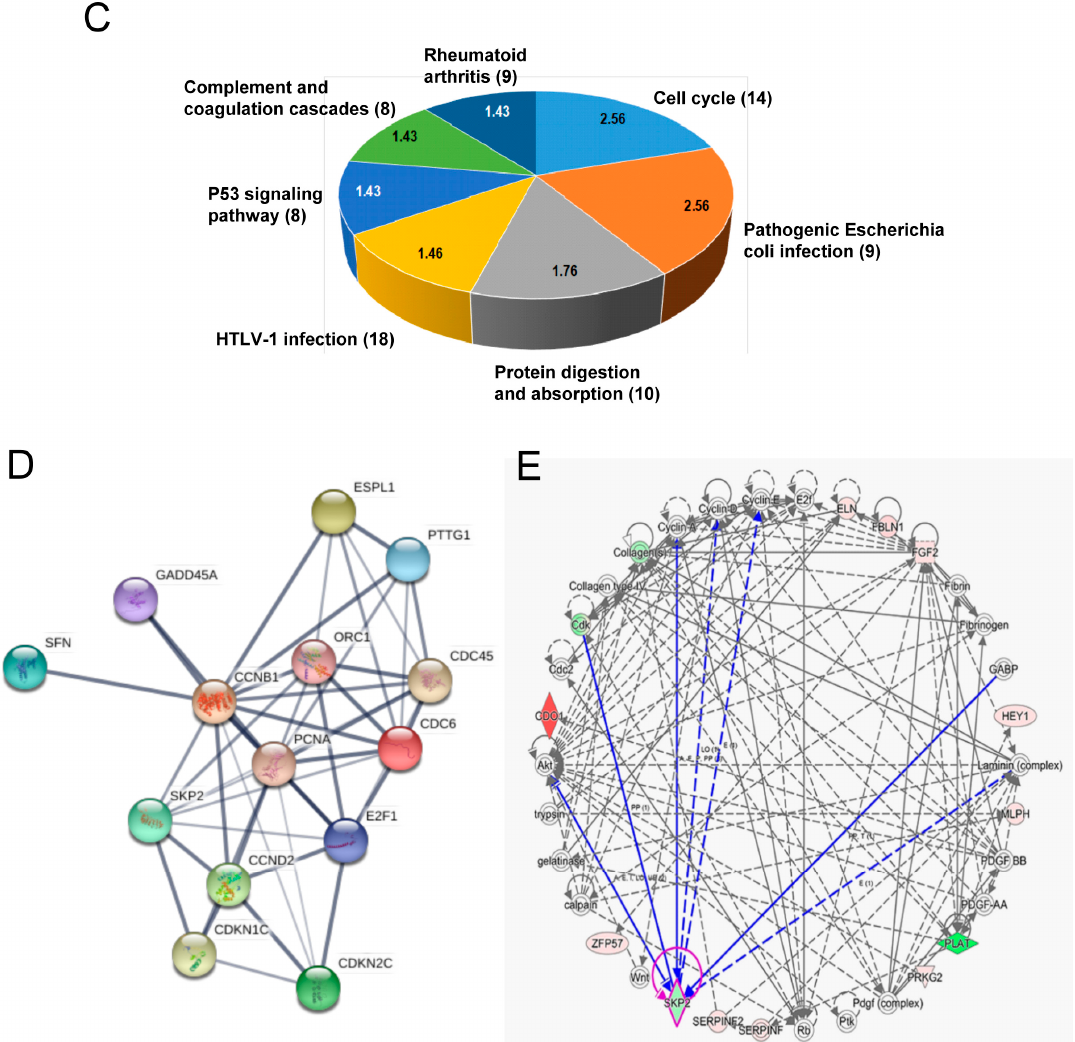
Figure 2. Identification of potential genes associated with cell senescence in PTECs in DN. ( A ) Flowchart of identification of potential genes associated with cell senescence in PTECs. ( B ) Display of differential expression patterns of normal and diabetic PTECs from deep RNA sequencing by volcano plot. ( C ) The Kyoto Encyclopedia of Genes and Genomes (KEGG) pathway enrichment analysis of differentially expressed genes in DAVID database. The 612 differentially expressed genes in diabetic PTECs were uploaded into DAVID database for enrichment analysis. The top seven KEGG pathway analysis results of these dysregulated genes in diabetic PTECs are displayed in a pie chart. The pie chart indicates the-Log10 (false discovery rate, FDR) of each KEGG term, and the numbers that are shown at the outside of each pie segment indicates the number of genes involved in each term. ( D ) The protein-protein interaction network analysis of 14 genes associated cell cycle of KEGG pathway using STRING database. S-phase kinase protein 2 (Skp2) correlated with cell cycle markers, such as cyclin D2 (CCND2), cyclin B1 (CCNB1), cyclin-dependent kinase inhibitor 1C (CDKN1C), and CDKN2C. ( E ) The potential network of Skp2 mediating cell cycle in Core analysis of Ingenuity Pathway Analysis (IPA) software. Skp2 correlated with cyclins.